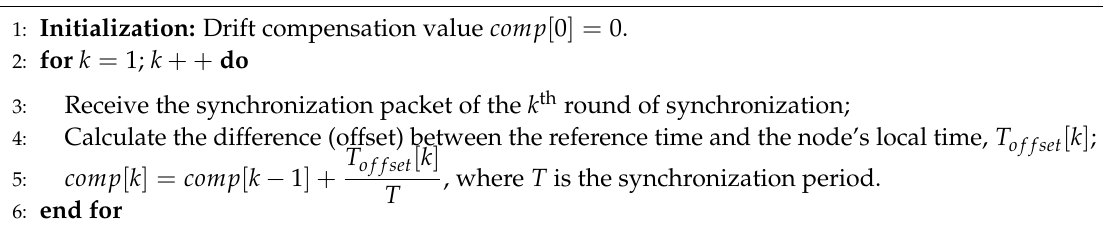
Algorithm 1 Drift compensation in the Sensor Array Synchronization Protocol